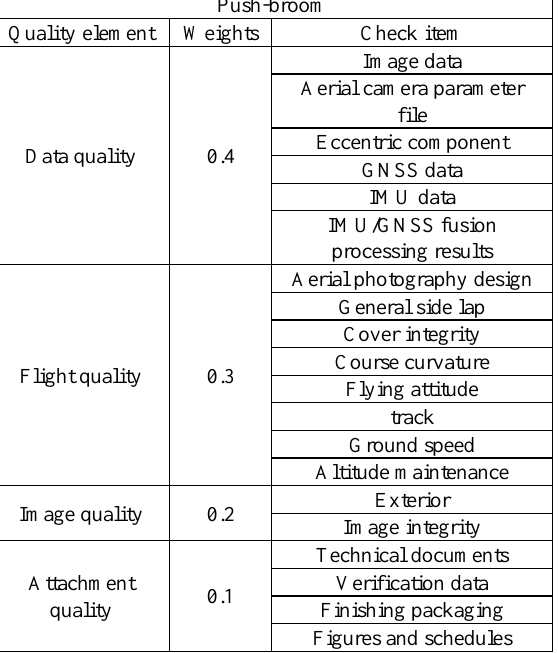
Table 2 . Quality elements and rights of digital aerial photography